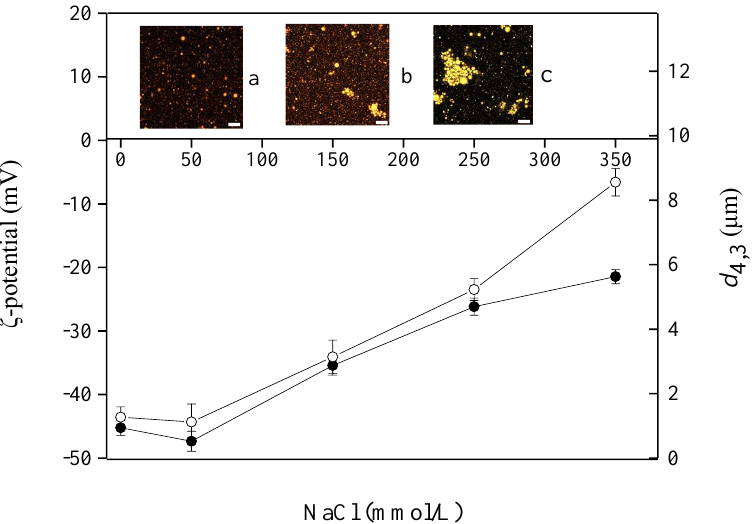
Figure 4. Influence of salt concentration on ζ -potential ( ● ) and d 4,3 ( ○ ) of PSP-stabilized emulsions. Insets show the CLSM microstructures at ( a ) 50 mmol/L NaCl, ( b ) 150 mmol/L NaCl and ( c ) 250 mmol/L NaCl. Scale bar in the micrographs corresponds to 10 μ m. Values are means ± SDs (n = 3).